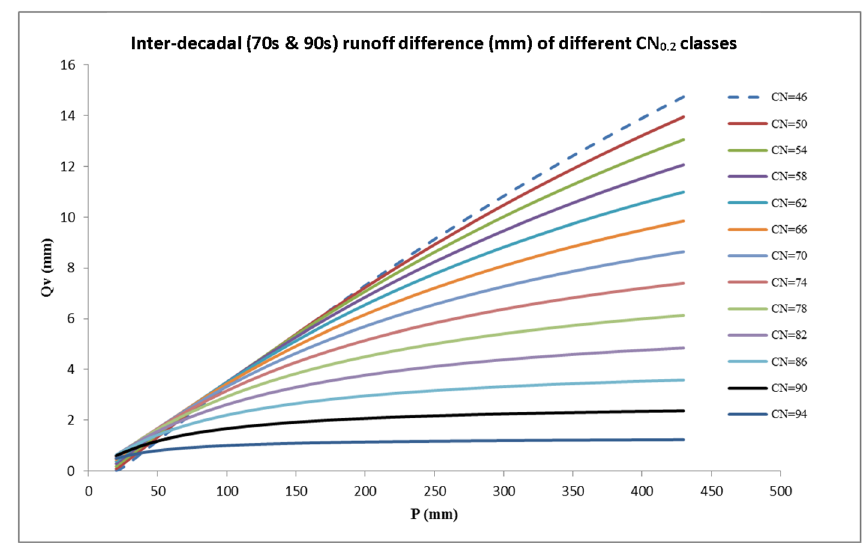
runo ff change between M70 and M80 under di ff erent rainfall depths.